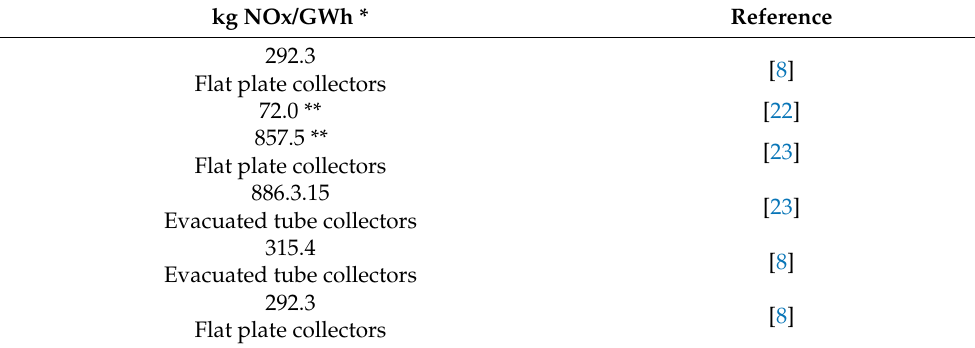
Table 7. NO x emissions (DHW